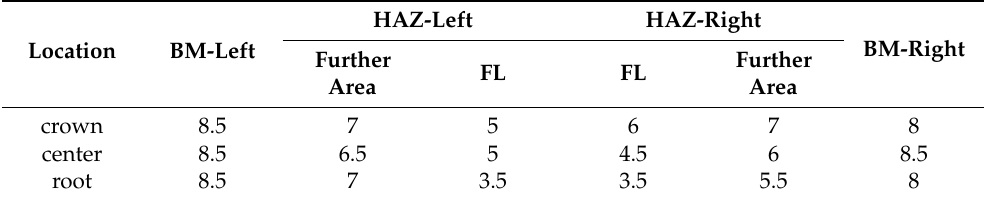
Table 6. Grain size G in the N sample, aged at 700 ◦ C for 15,000 h.